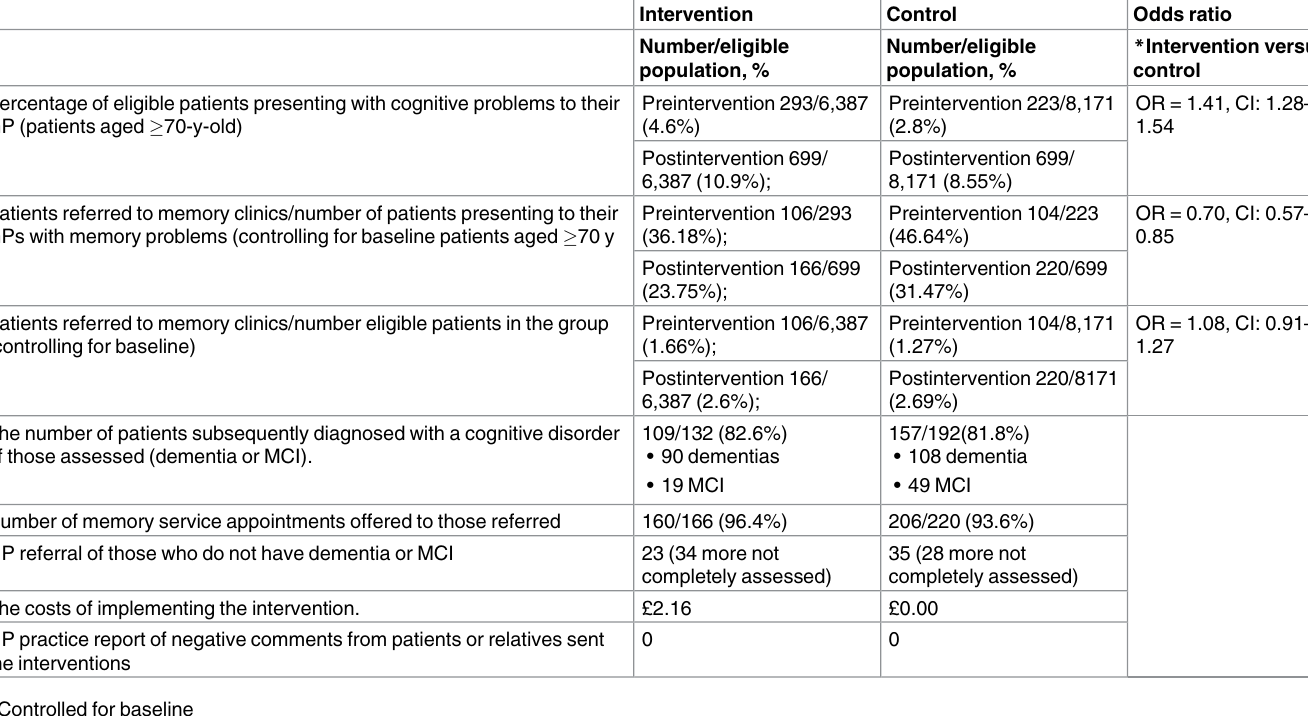
Table 3. Secondary outcomes for intervention groups versus control in the year after intervention.